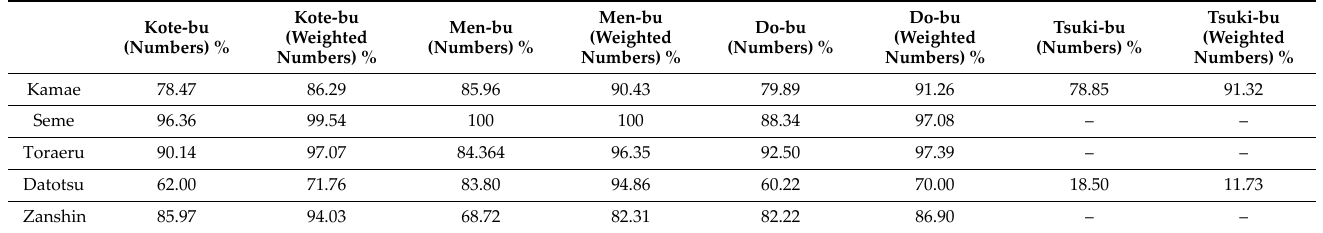
Table 1. Percentage of instances with left‑hand pressure greater than right‑hand pressure across all phases per attack technique of 10 attacks per technique and participant; relative numbers (%) and relative weighted numbers (%, higher pressure has greater weight).